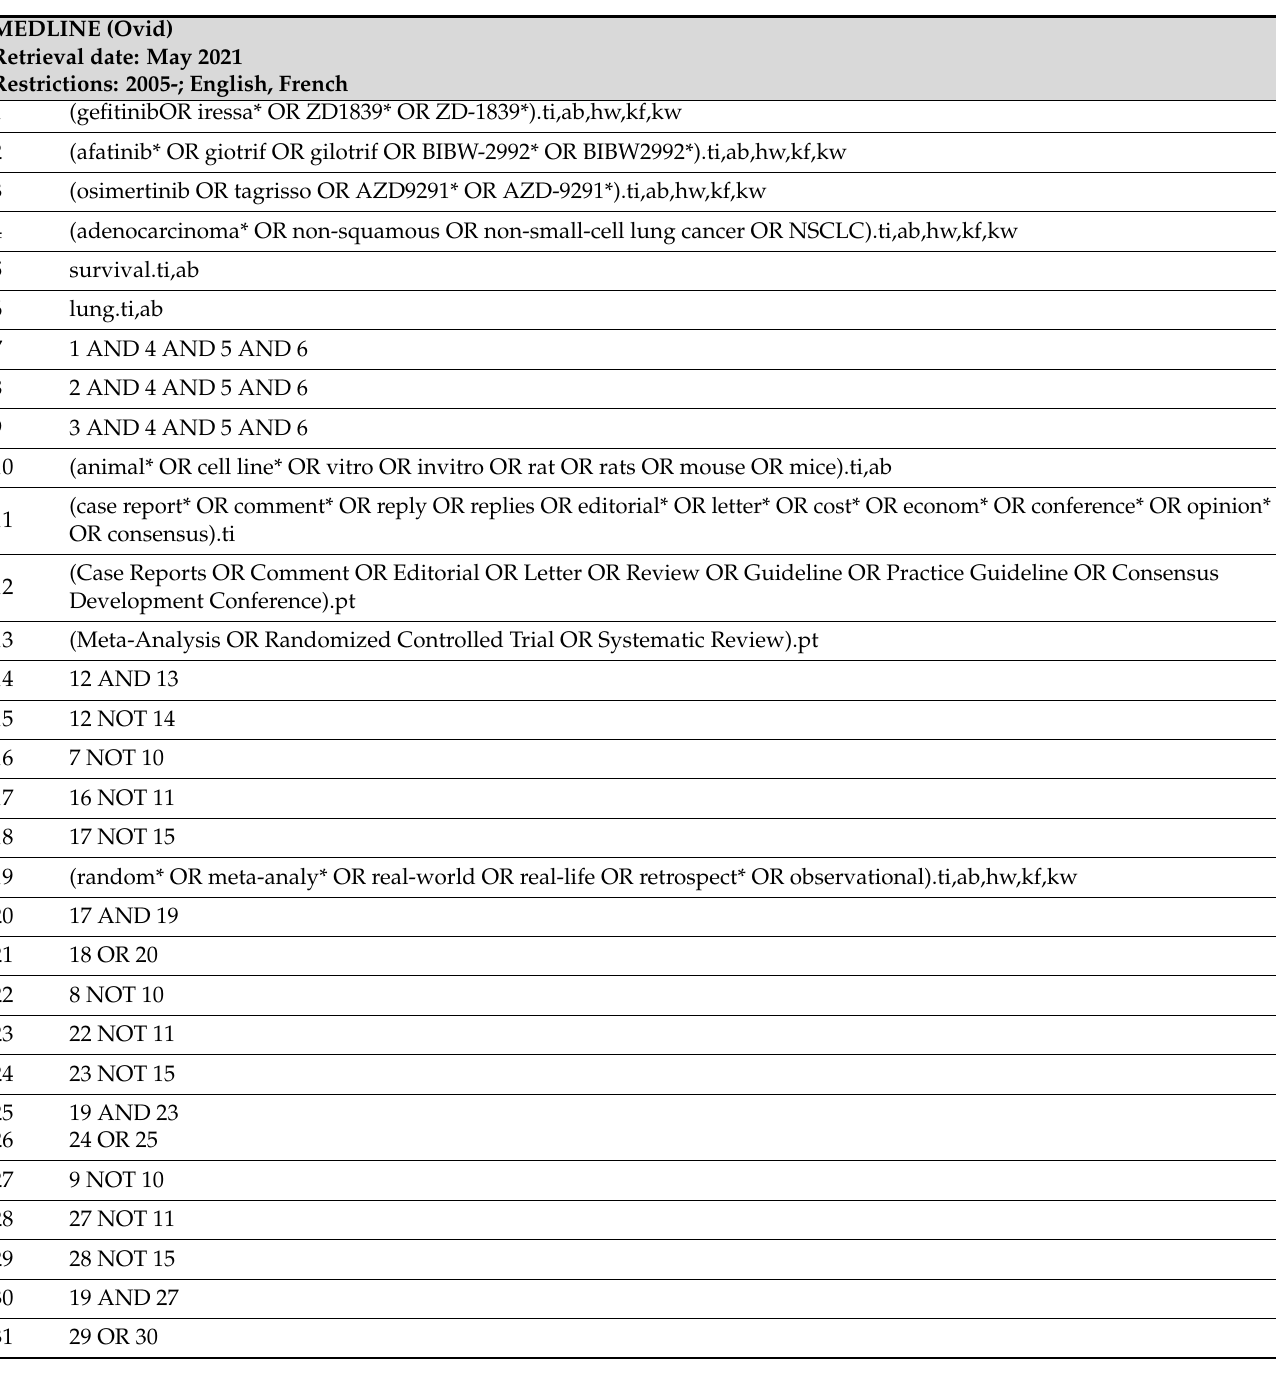
Table A6. Search